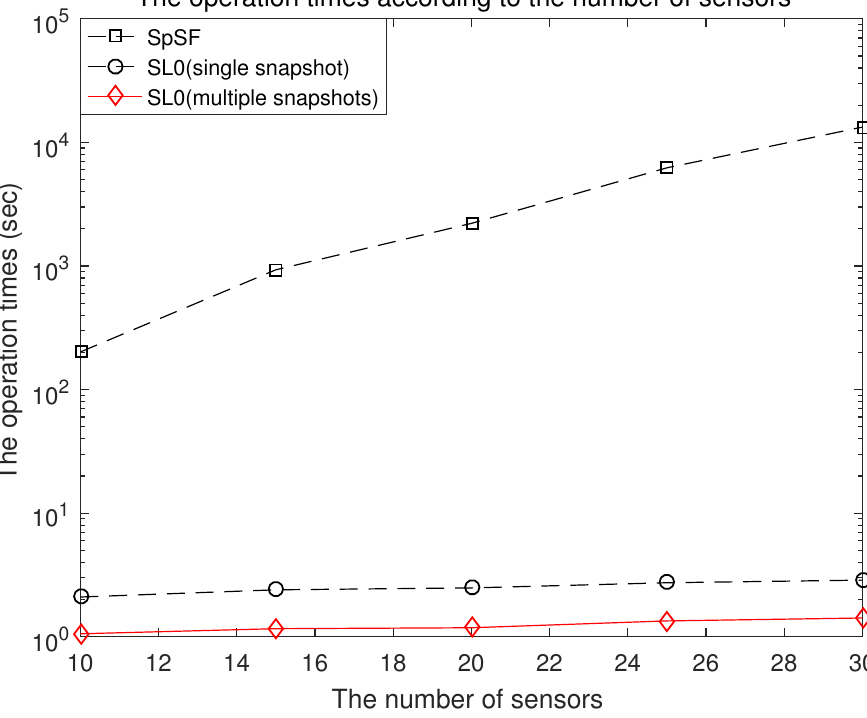
Figure 9. The operation times of the proposed scheme, multiple snapshots SL0 and